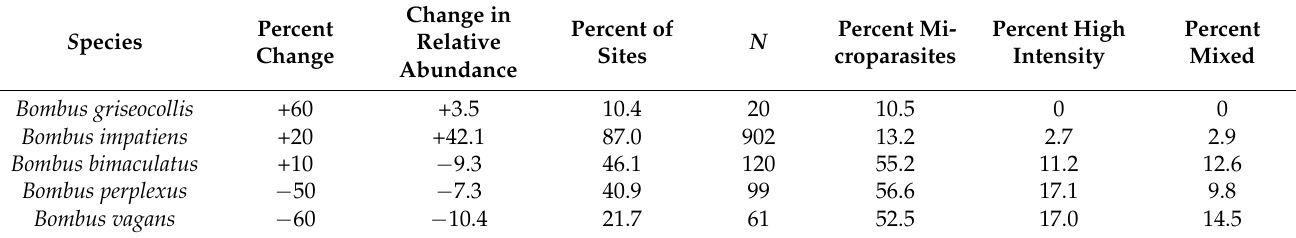
Table 1. Changes in the percent of sites where species was collected (Percent Change) and relative abundance (Change in Abundance) revealed in a previously reported long-term survey (1990–2017) in our study region [11,12], and data from the present study showing the percent of sites where each species was collected (Percent of Sites), the total number of each species collected ( N ), the percent of samples with microparasites (Percent Microparasites), the percent of samples with high-intensity infections (Percent High Intensity), and the percent of samples with multiple infections (Percent